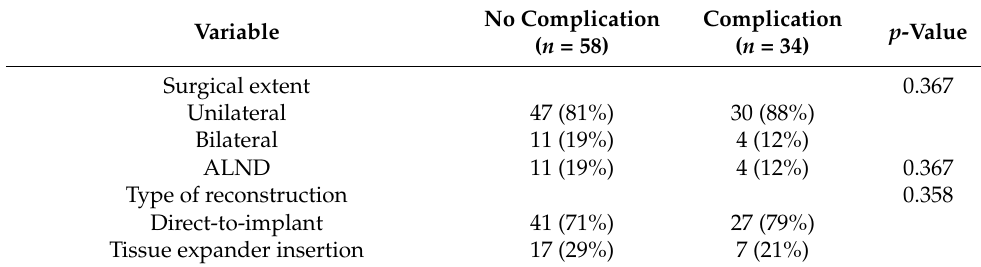
Table 2. Operative